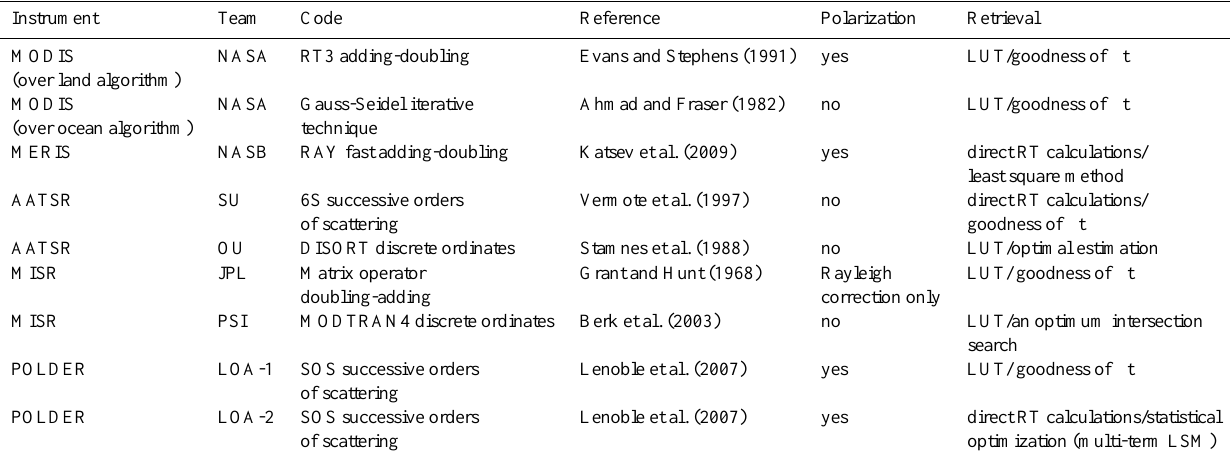
Table 2. The radiative transfer models used in this